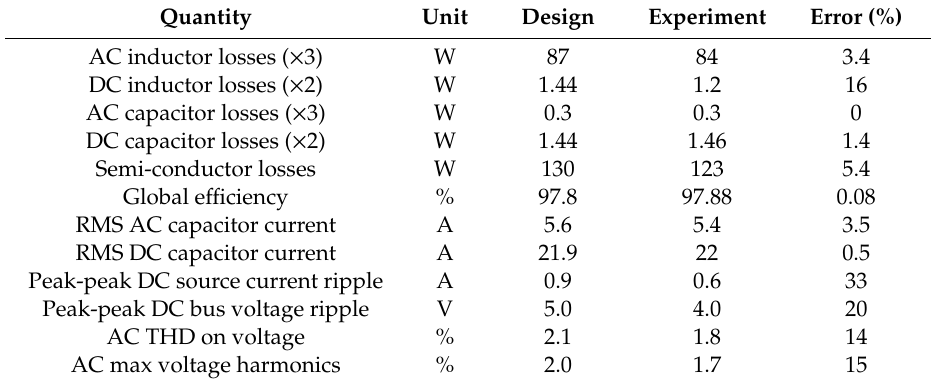
Table 4. Comparisons between optimization results and experiments for the powder core solution.